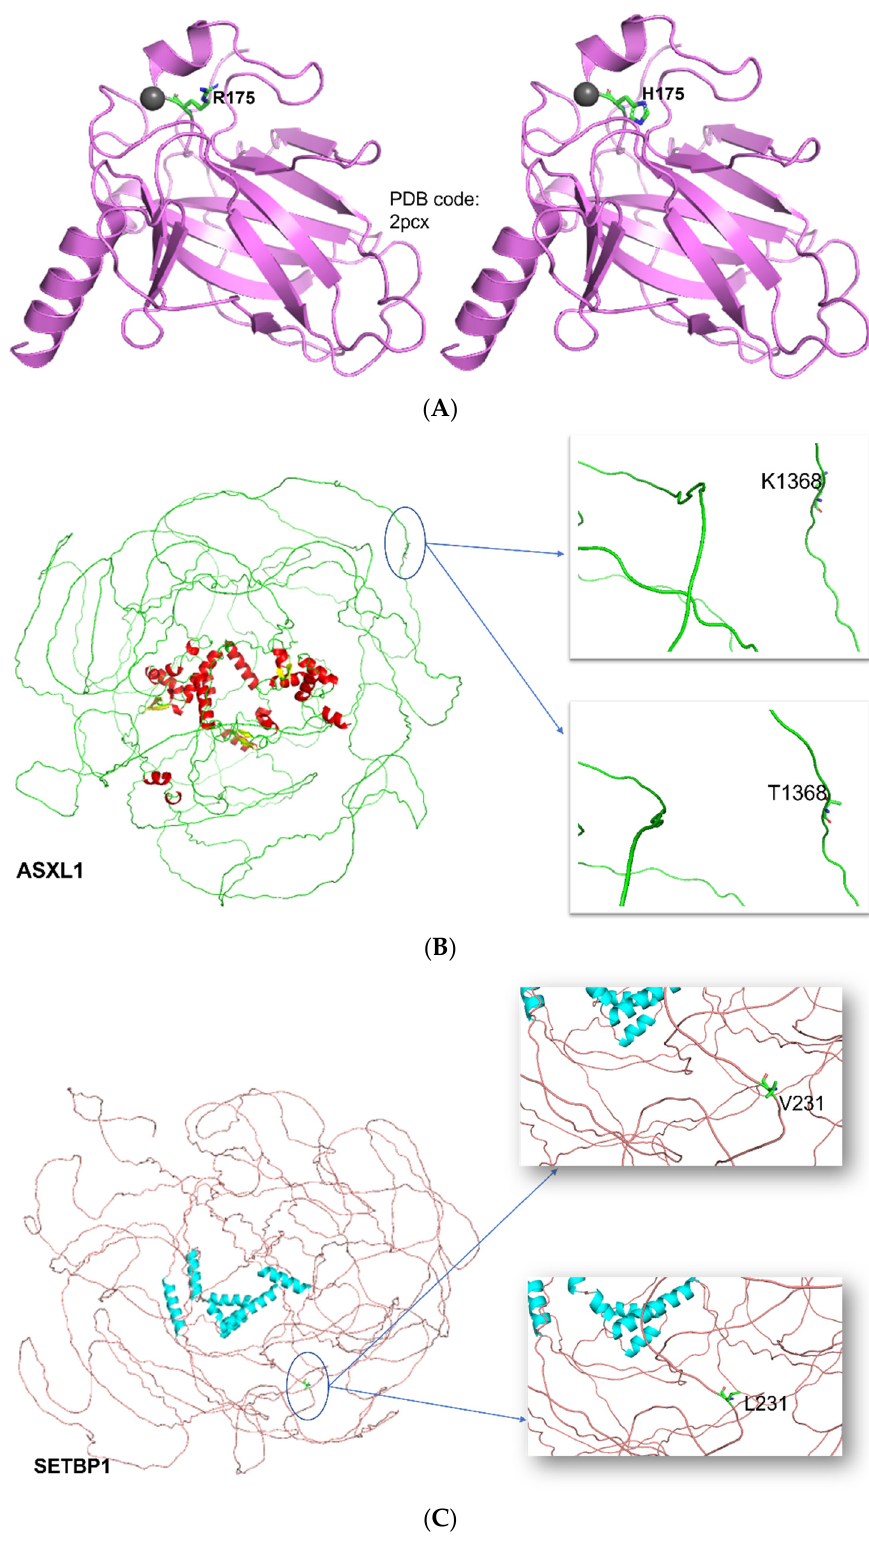
Figure 4. Structural reflection of the mutations. ( A ) Three ‐ dimensional structure of p53 showing wild (R175) and mutated (H175); zinc atom shown as grey sphere. ( B ) Three ‐ dimensional structure of ASXL1 showing wild (K1368) and mutated (T1368). ( C ) Three ‐ dimensional structure of SETBP1 showing wild (V231) and mutated (L231).